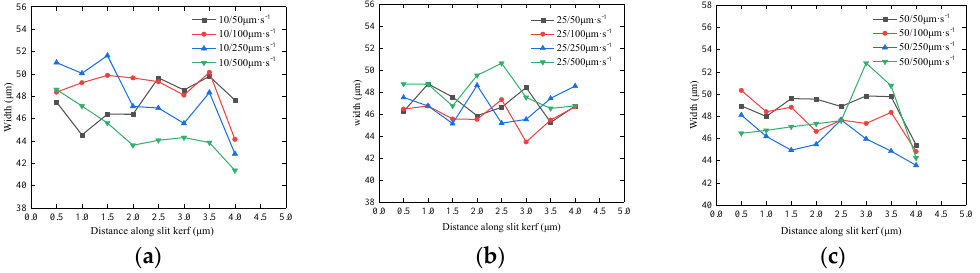
Figure 7. Width data of slits with different initial velocities: ( a ) 10 μm·s −1 ; ( b ) 25 μm·s −1 ; ( c ) 50 μm·s −1 .